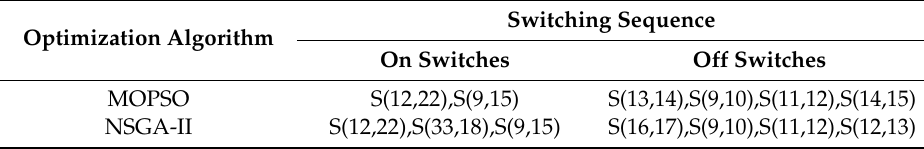
Table 9. Switching sequence obtained when the fault occurred between bus 10 and 11 for the DC drive load